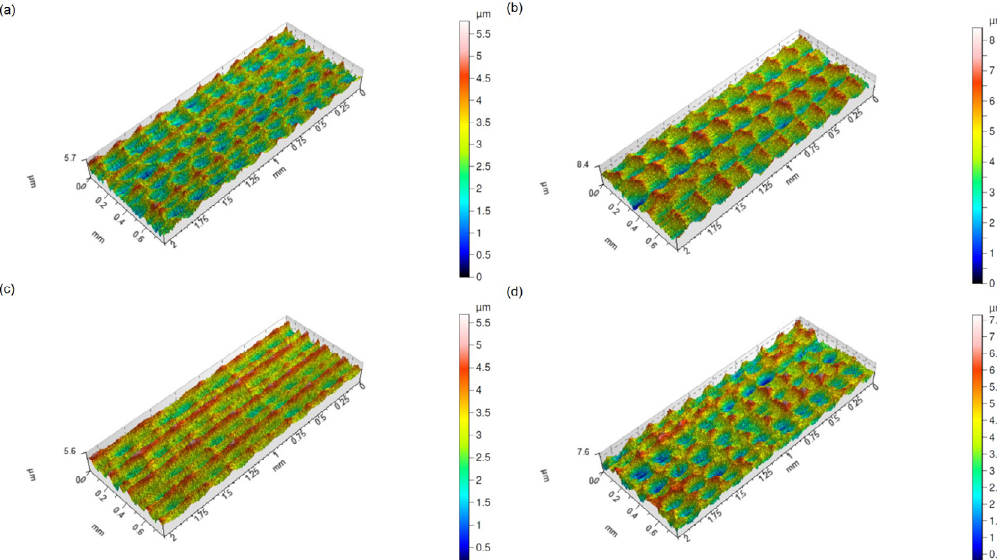
Figure 9. Surface topographies generated by horizontal tool path orientations at inclined workpiece angle of 75º (a) HUD, (b) HUU, (c) HDD, (d)